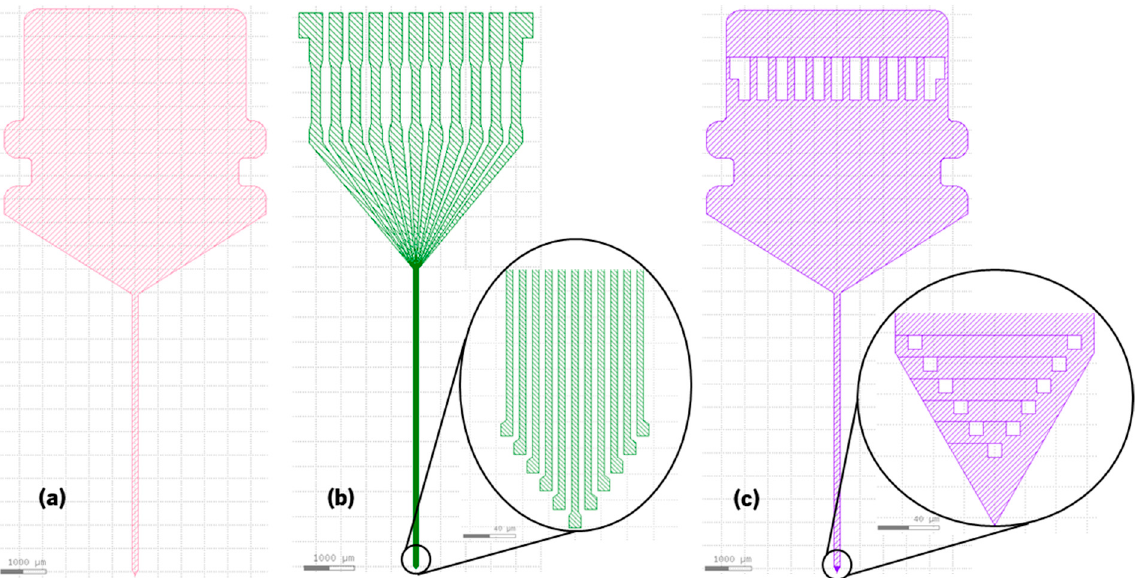
Figure 1. µMLA digital masks to pattern: ( a ) neural probe geometry; ( b ) neural probe contact pads, tracks and microelectrodes; ( c ) neural probe passivation.